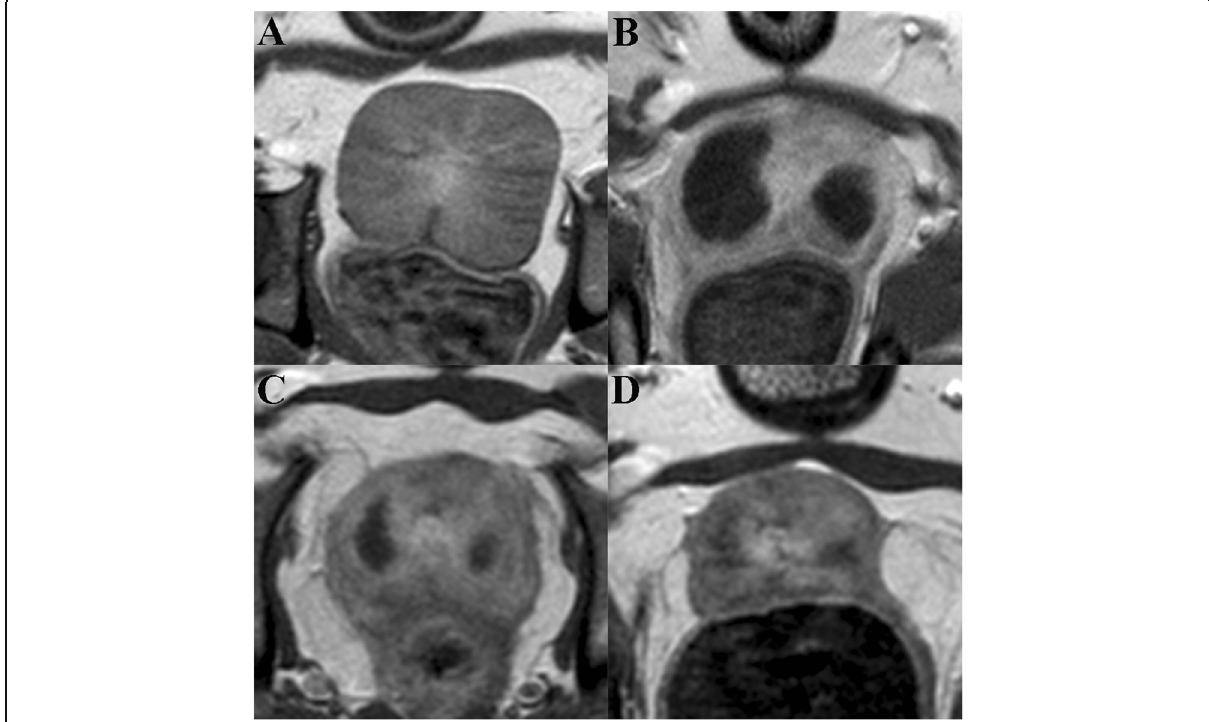
Fig. 2 Contrast enhanced axial T1-weighted. MR images show the prostate immediately before PAE ( a ), 1 week ( b ), 2 weeks ( c ), and 1 month ( d ) after PAE. The infarct lesions lacking of enhancement gradually decrease in size with time and the prostate shrinks substantially at